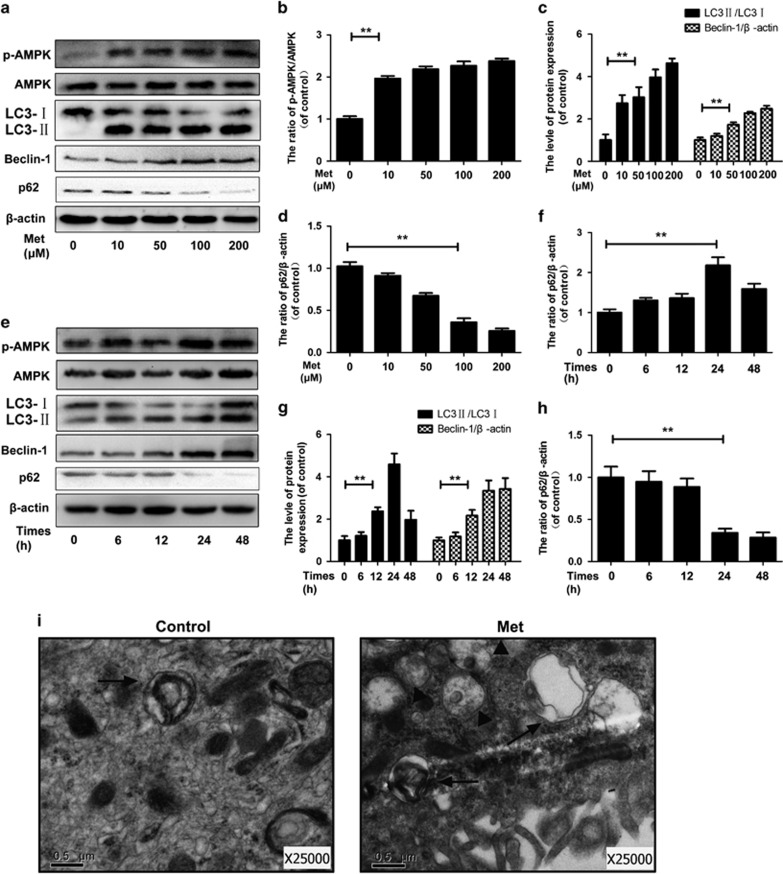
Metformin treatment induces autophagy in the nucleus pulposus cells. The nucleus pulposus cells were incubated with 0, 10, 50, 100 or 200 μM metformin for 24 h or 100 μM metformin for 0, 6, 12, 24 or 48 h. (a–h) Protein content of p-AMPK, AMPK, LC3, Beclin-1 and p62 of nucleus pulposus cells as treated above. (i) Autophagosomes and autophagolysosomes were detected by transmission electron microscopy (× 25000) in nucleus pulposus cells. (Black arrow: autophagosome; black triangle: autophagolysosome). The data in the figures represent the averages±S.D. Significant differences between the treatment and control groups are indicated as **P<0.01,*P<0.05, n=3